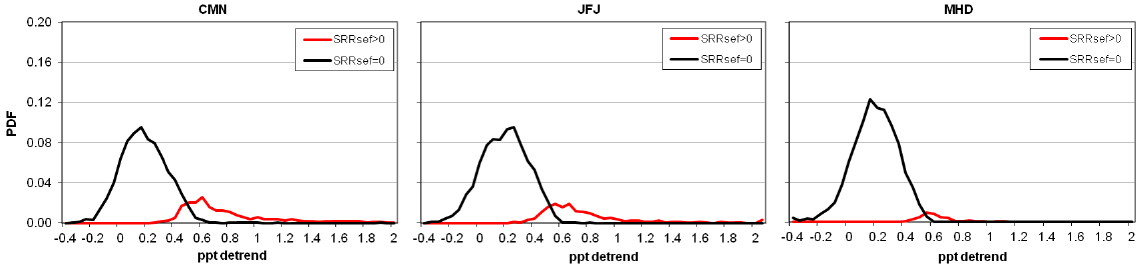
Figure 7. Probability density function (PDF) distribution of the MCF detrended time series measured at the three sites (left: CMN; middle: JFJ; right: MHD) in the years 2008–2009. Black lines, sensitivity to the SEF region: SRR SEF = 0; red lines, sensitivity to the SEF region: SRR SEF >0.